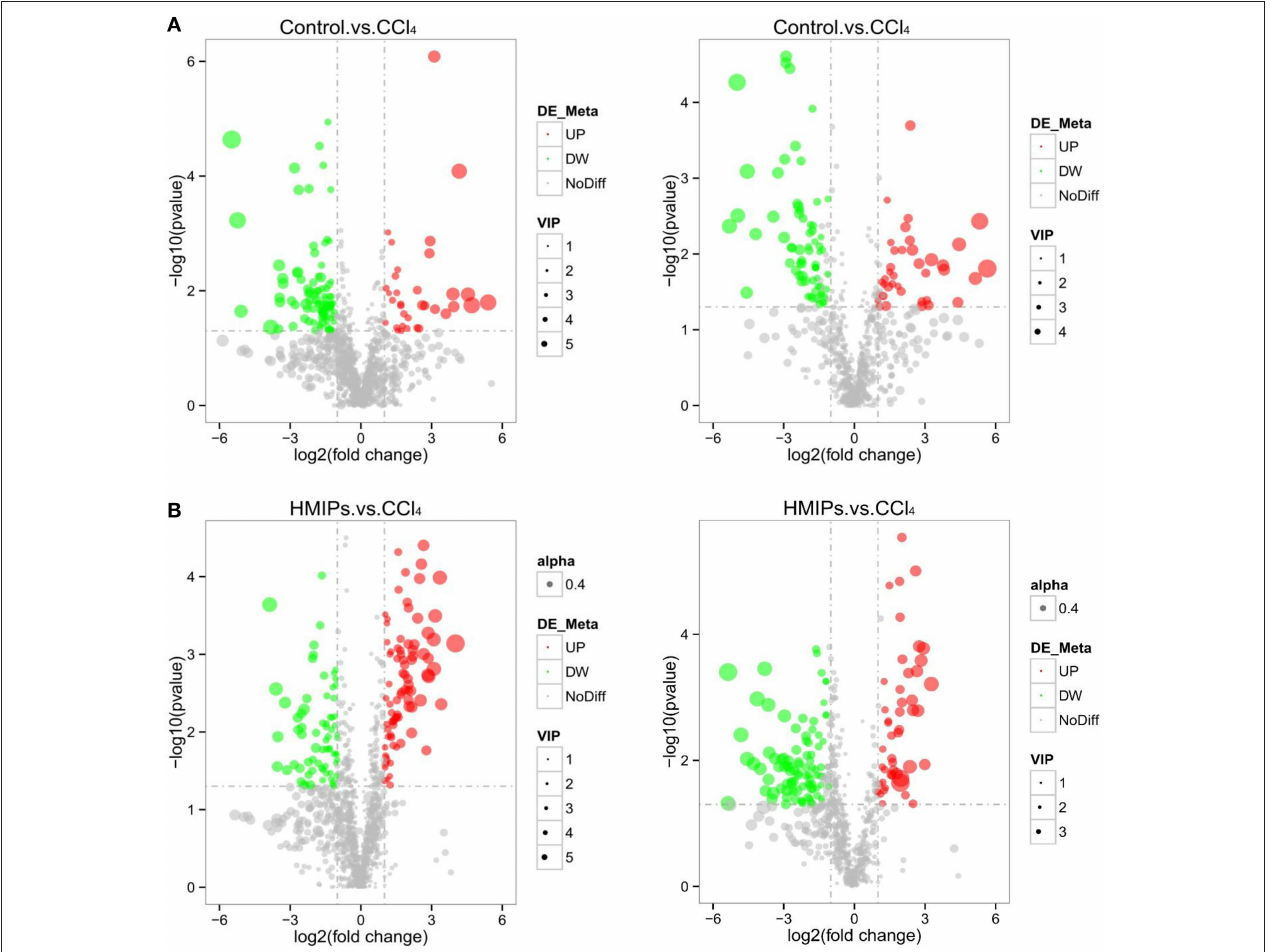
FIGURE 9 | Volcano plot of the serum samples. (A) Volcano plot of the control and CCl 4 groups under the positive and negative ion models. (B) Volcano plot of the HMIP and CCl 4 groups under the positive and negative ion models. Significantly increased (decreased) variables are represented in the red (green)